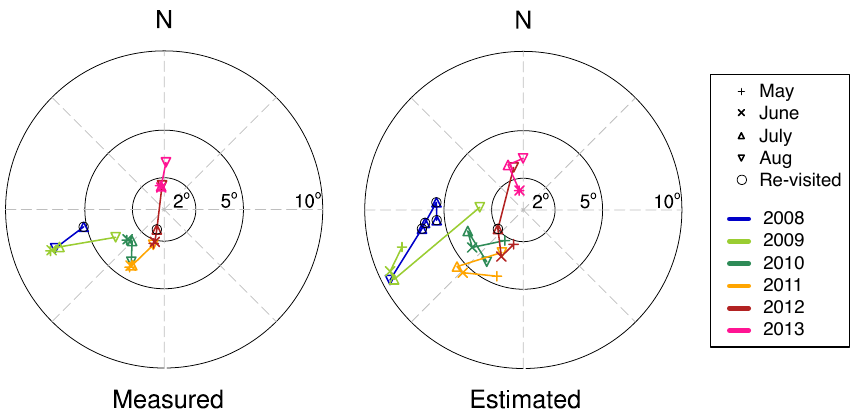
Figure 4. Measured and estimated tilt angle and tilt direction at the KPC_U station. The distance from the circle center represents the station tilt angle ( β ). The direction represents the station tilt direction ( a w ) with 0 ◦ pointing to the South. The markers are circled in black if the station was re-visited in those months.